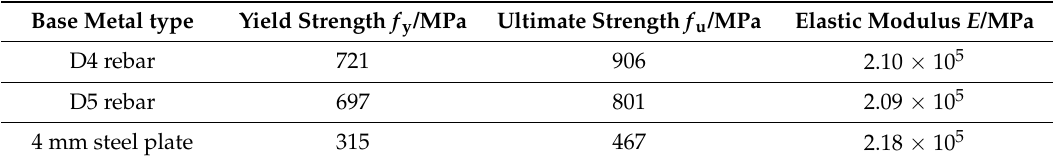
Table 3. Test results of steel plate and steel bars.